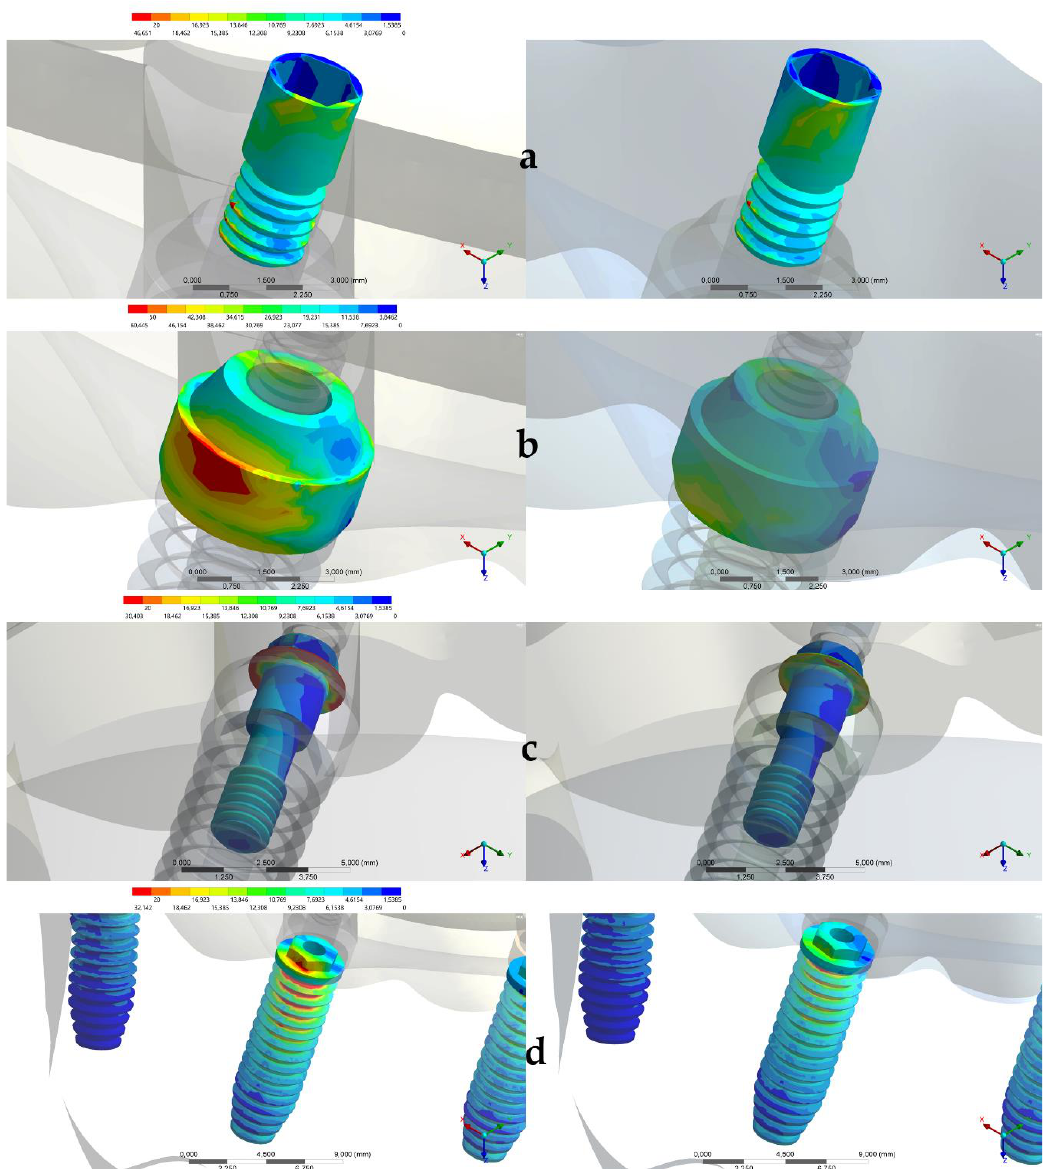
Figure 5. ( a – d ). An approximated view of the highest stress concentration maps in the conventional design (Left) and in the prosthesis experimental design (Right). ( a ) The prosthetic screw, ( b ) Abutment, ( c ) Abutment screw and ( d ) Implants.